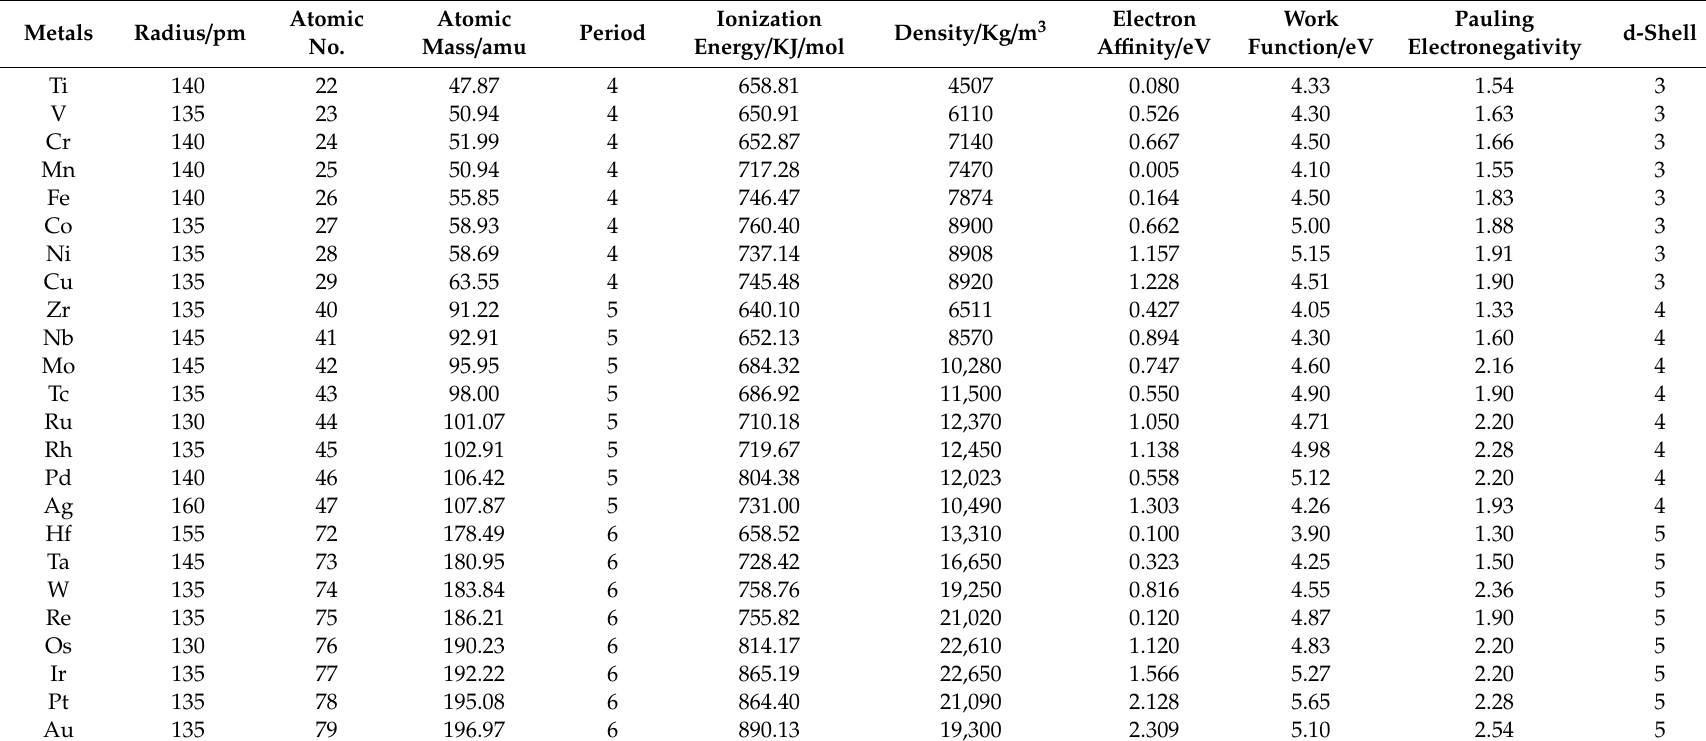
Table 1. Elemental properties of transition metals used as